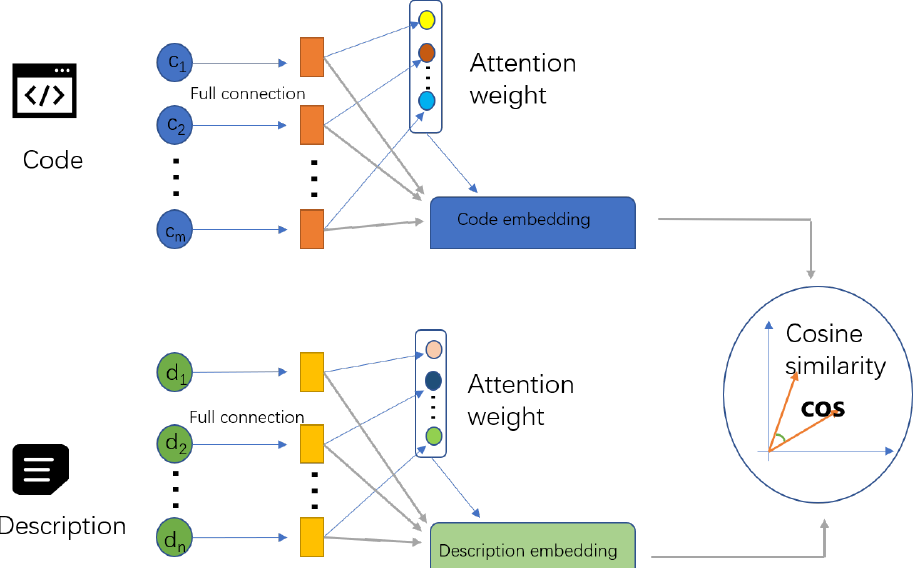
Figure 2. Details in Teacher Models whose encoder is